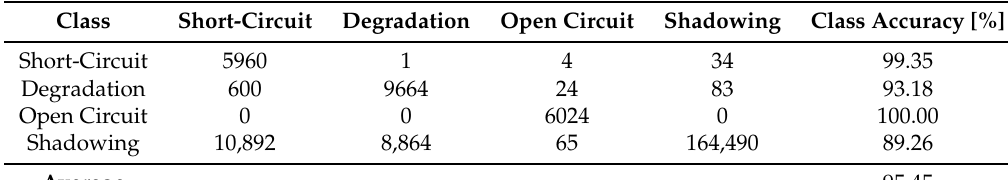
Table 12. Classification Confusion Matrix.